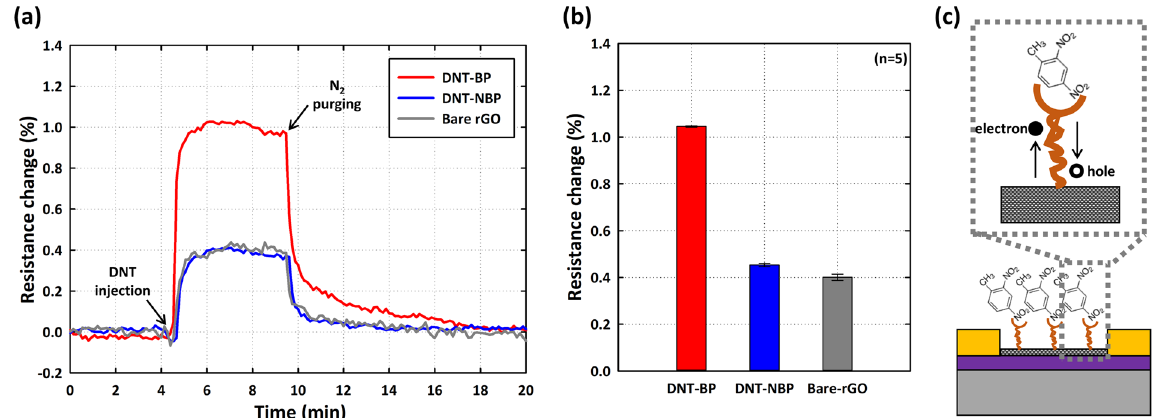
Figure 3. DNT detection using the DNT-bp, DNT-nbp, and bare rGO sensor surfaces: ( a ) Real-time monitoring of the resistance change with multi-functionalized rGO sensors. ( b ) Average resistance changes of five independent multi-functionalized rGO sensors. The red, blue, and gray bars represent the DNT-bp, DNT-nbp, and bare rGO sensors, respectively. The error bars indicate the standard deviation. ( c ) Schematic illustration of the equivalent effect of DNT detection with DNT-bp and